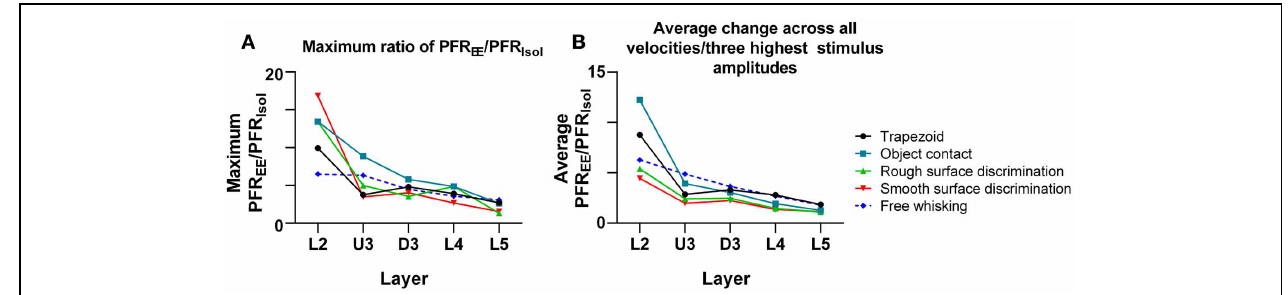
FIGURE 9 | Depth-dependent changes in maximum and average PFR EE / PFR Isol ratios. (A) Maximum PFR EE /PFR Isol ratio in all stimuli plotted across all cortical layers. The maximum PFR EE /PFR Isol ratio is in supragranular layers for all stimuli, and steadily declines as cortical depth increases. (B) Average PFR EE /PFR Isol ratio in all stimuli from all onset ramp velocities/3 highest